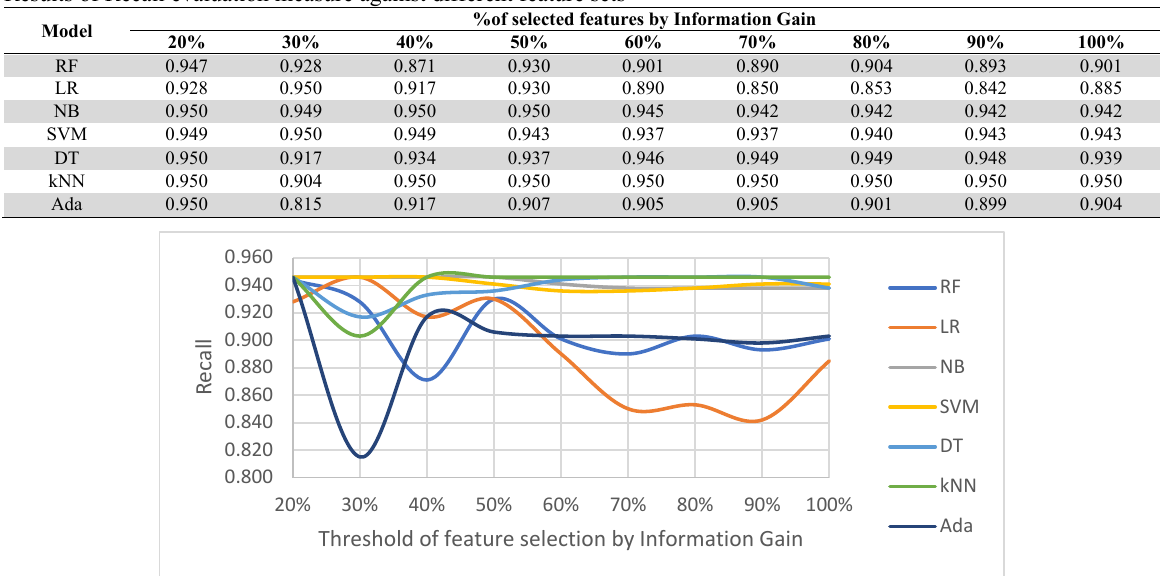
Fig. 9. Recall results for the comparison between different machine learning models using